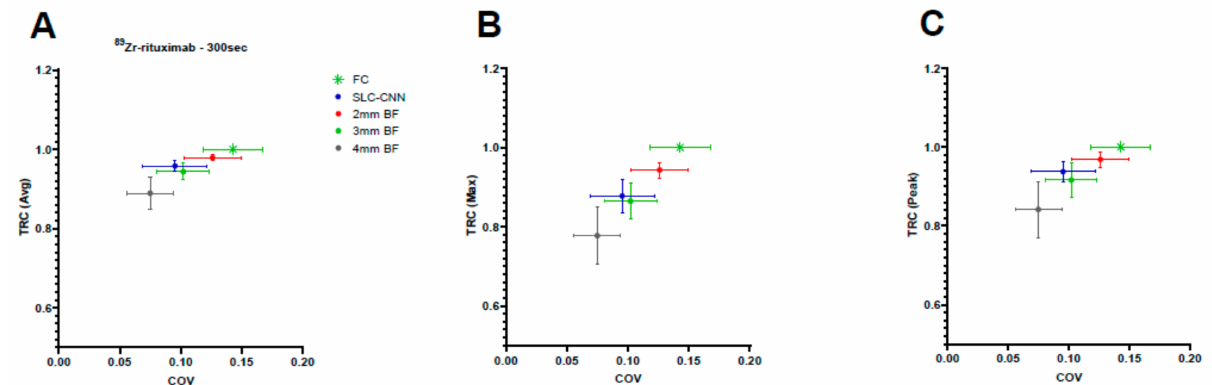
Figure 3. The performance of the denoising methods for low-count 89 Zr-rituximab PET. The ( A ) aver- age, ( B ) maximum, ( C ) 3Dpeak TRC of the SLC-CNN and BF (2 mm, 3 mm and 4 mm) denoising methods of the FC 89 Zr-rituximab PET from the Ingenuity TF PET/CT scanner.